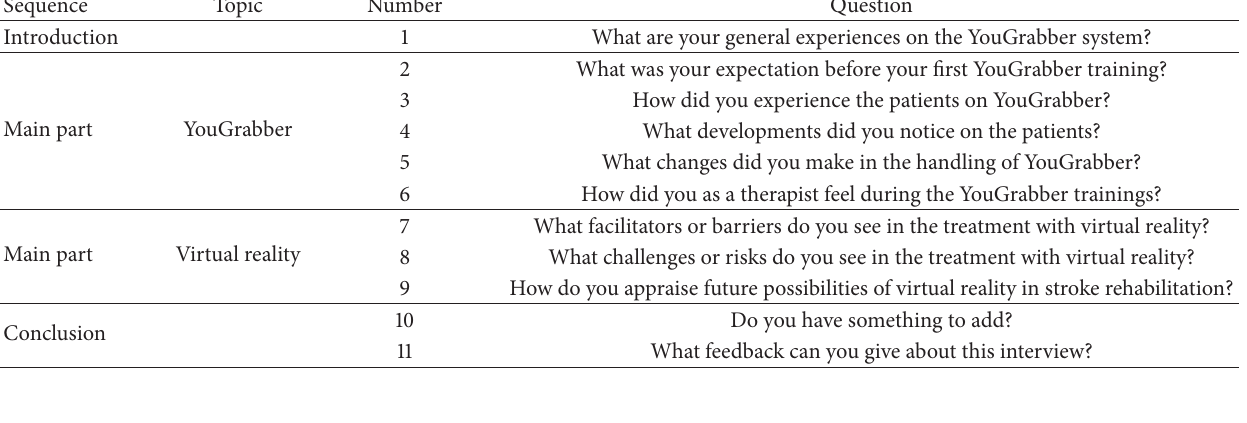
Table 3: Interview guide for focus groups.